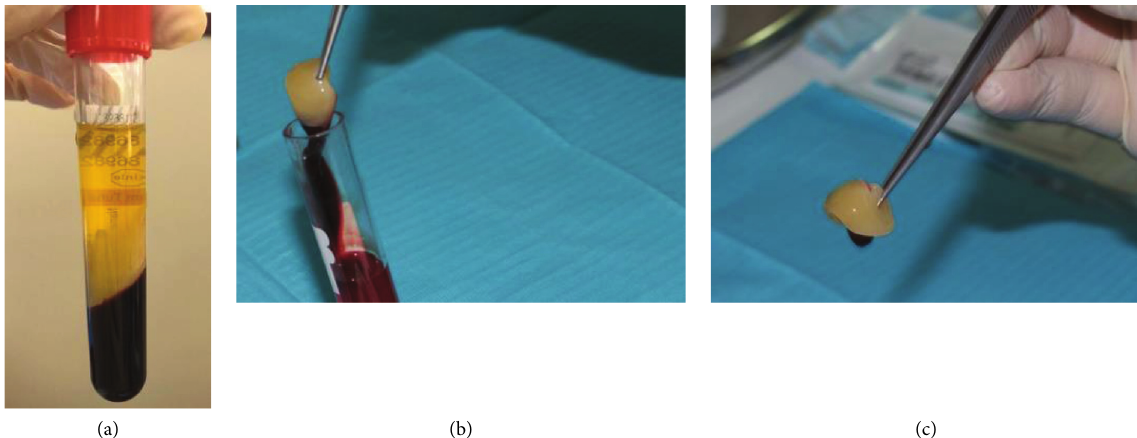
Figure 1: (a) Blood sample after centrifugation. (b) Extracting the PRF clot from the tube with sterile tweezer. (c) The fibrin clot is separated from the RBC fragment.